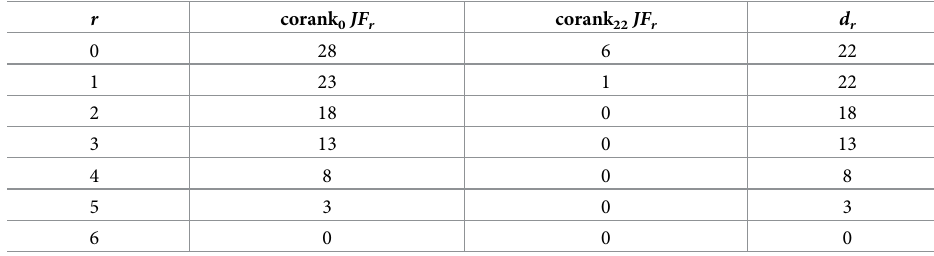
Table 7. Summary of computations showing model is